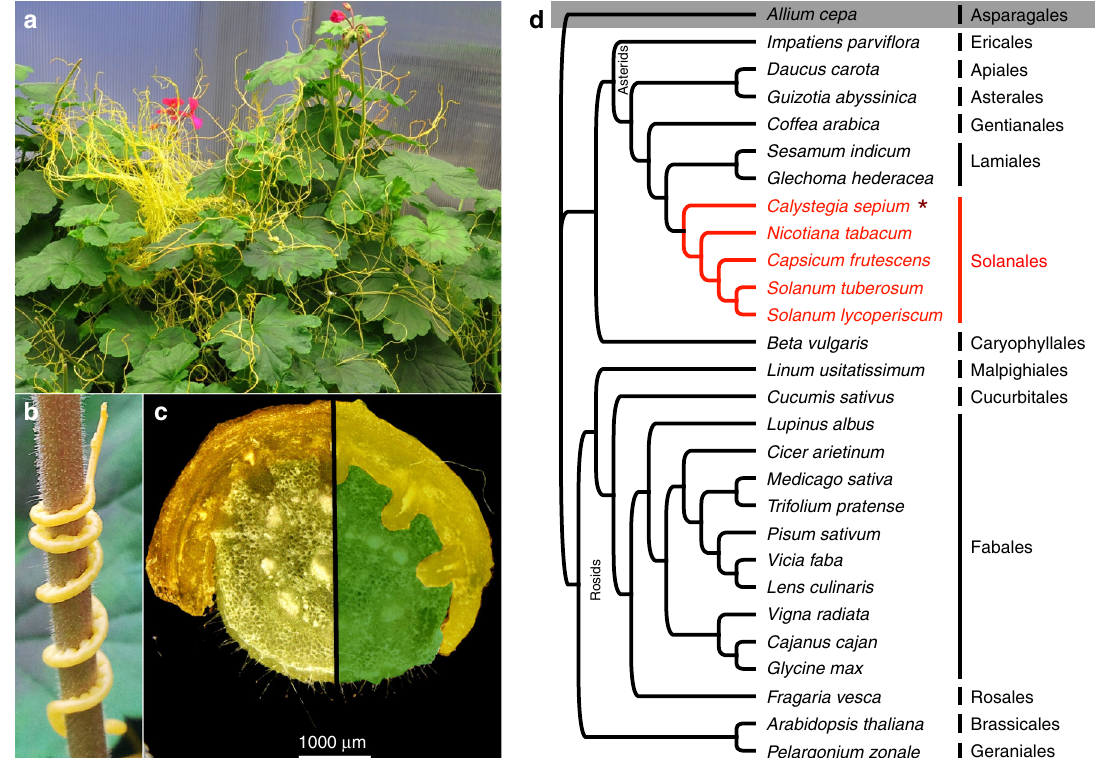
Fig. 1 Cuscuta campestris — host plant relationship. a Cuscuta campestris (yellow) infecting Pelargonium zonale . b Close-up of a parasitic vine entwining and infecting a host shoot. c Cross section through an infection site. The right half of the micrograph was overlayed with color to emphasize the border between C. campestris (yellow) and the P . zonale stem (green). d Simpli fi ed phylogenetic tree of reported host plant species of C. campestris , showing the variety of angiosperm orders (named on the right) that contain host species (according to refs. 1 – 3 ). The gray background highlights the single described monocot host. The asterisk indicates the closest phylogenetic relative of C. campestris (Convolvulaceae) within the host